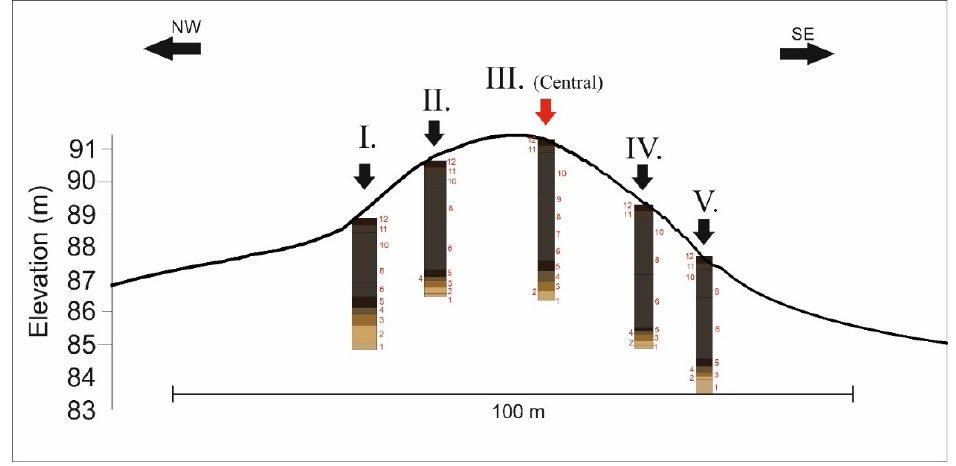
Figure 5. NW-SE transect of the mound and its different sediment and soil layers. Roman numbers: boreholes. Red numbers: (1). Yellowish-gray sandy layer, (2). Grayish-yellow sandy layer, (3). Yellowish-brown loessy layer, (4). Buried soil layer B horizon, (5). Buried soil layer A horizon, (6).